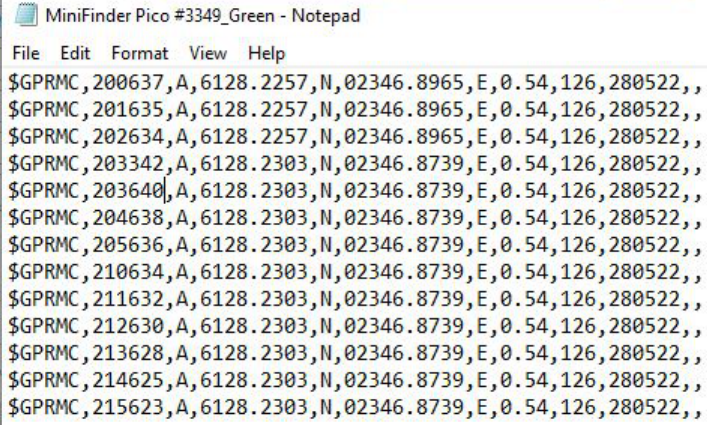
Figure 8. NMEA message showing outdoor tag